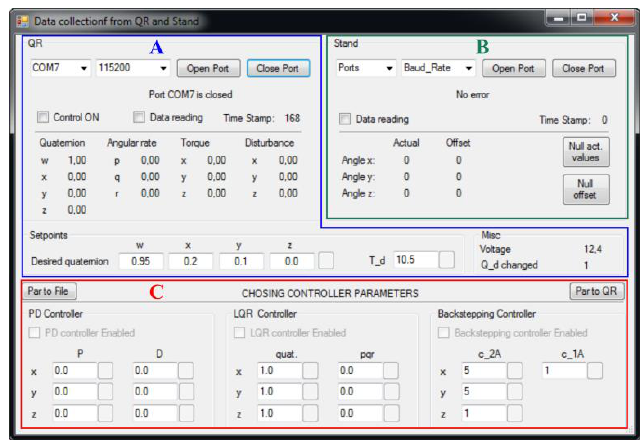
Figure 8. Application used to log data and send commands to the real platform.